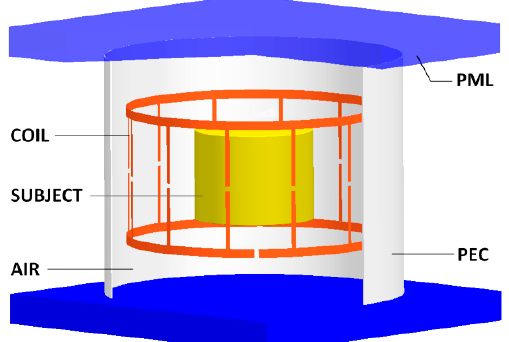
Figure 2. The finite-difference-time-domain (FDTD) configuration. Here, a 12-leg birdcage coil was modelled and loaded with a subject (phantom or head); a perfect electric conductor (PEC) was placed around the birdcage coil to simulate the RF shield, and perfectly matched layers (PML) boundary conditions were placed at the top and bottom of the computation domain. With the graphics processing unit (GPU) computing, the FDTD calculation of the electromagnetic (EM) fields only took about 18 s for the given case involving 1.4 million Yee-cells.